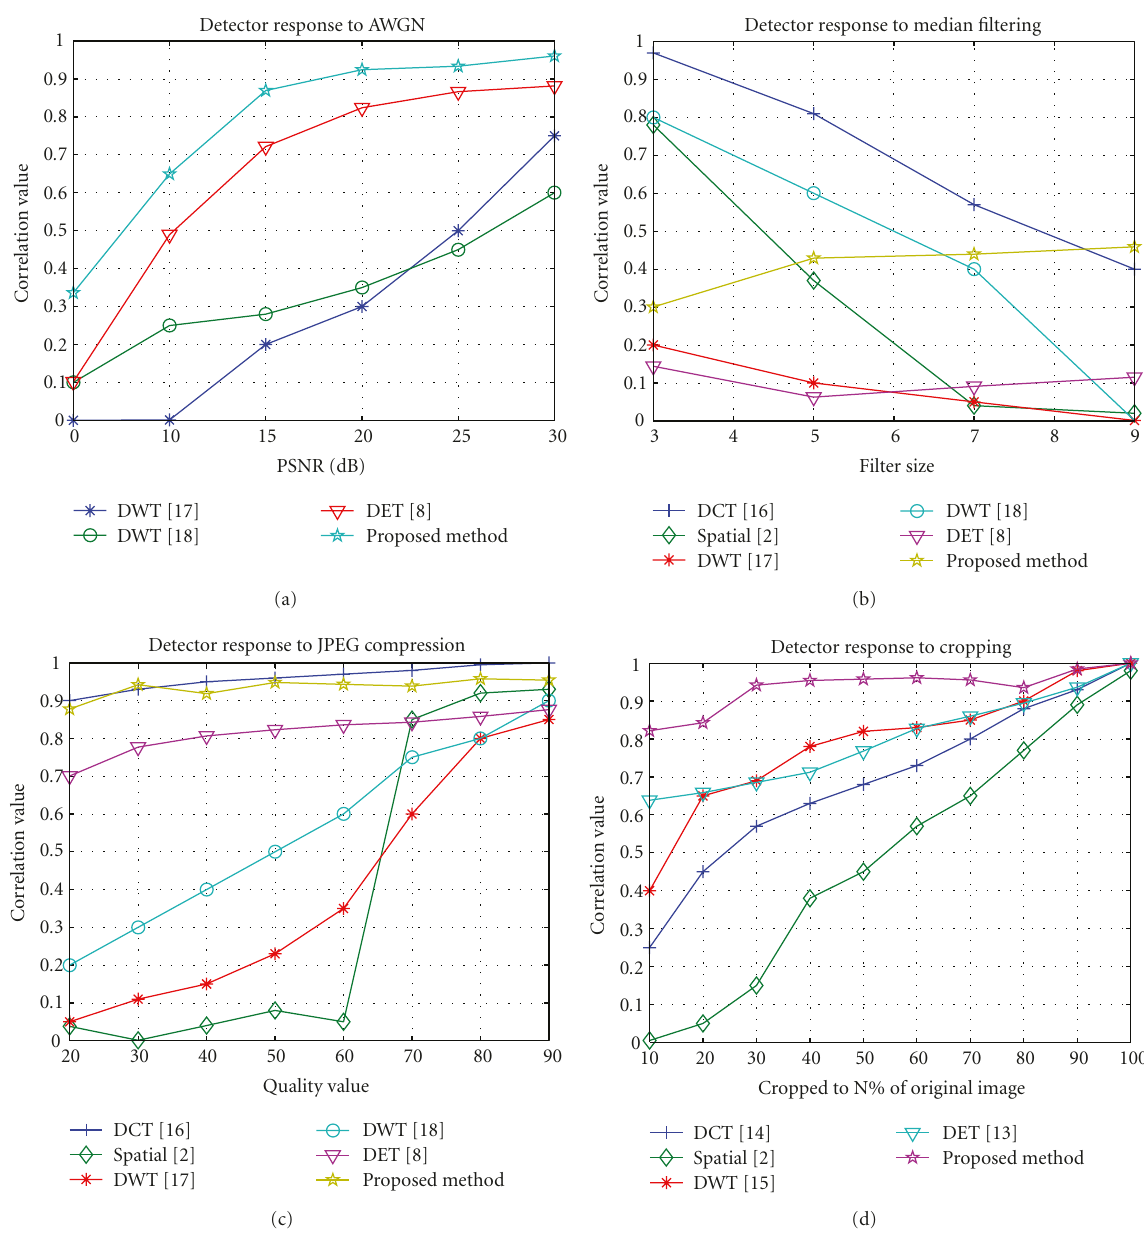
Figure 4: The comparison of the proposed method and the methods in [2, 8, 16–18] under (a) AWGN, (b) Median Filtering, (c) JPEG Compression, (d) Cropping